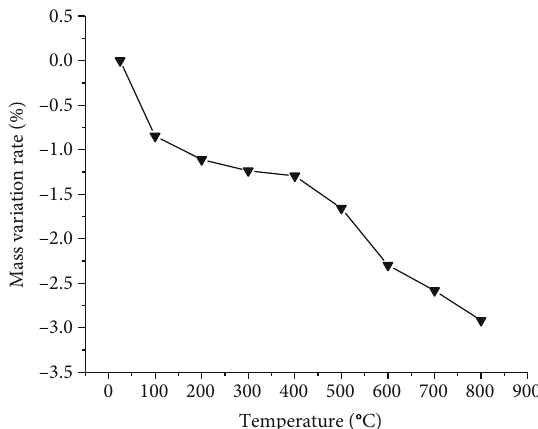
Figure 3: Mass variation rate of the heat-treated sandstone.